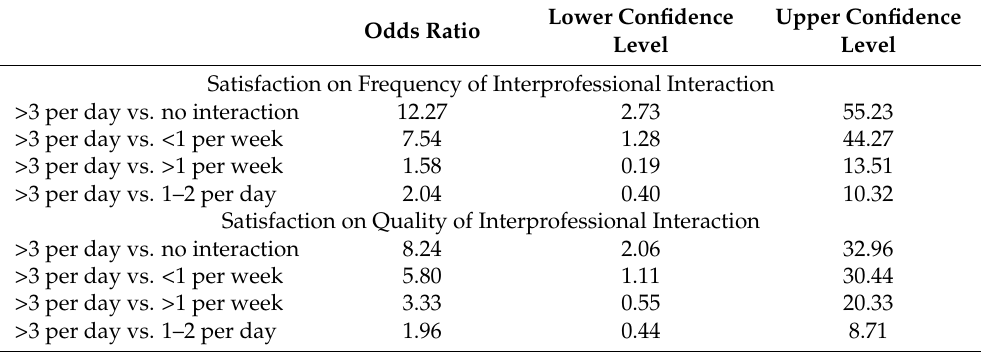
Table 3. Impact of COVID-19 on interprofessional satisfaction, n = 66. Lower Confidence Upper Confidence Odds Ratio Level Level Satisfaction on Frequency of Interprofessional